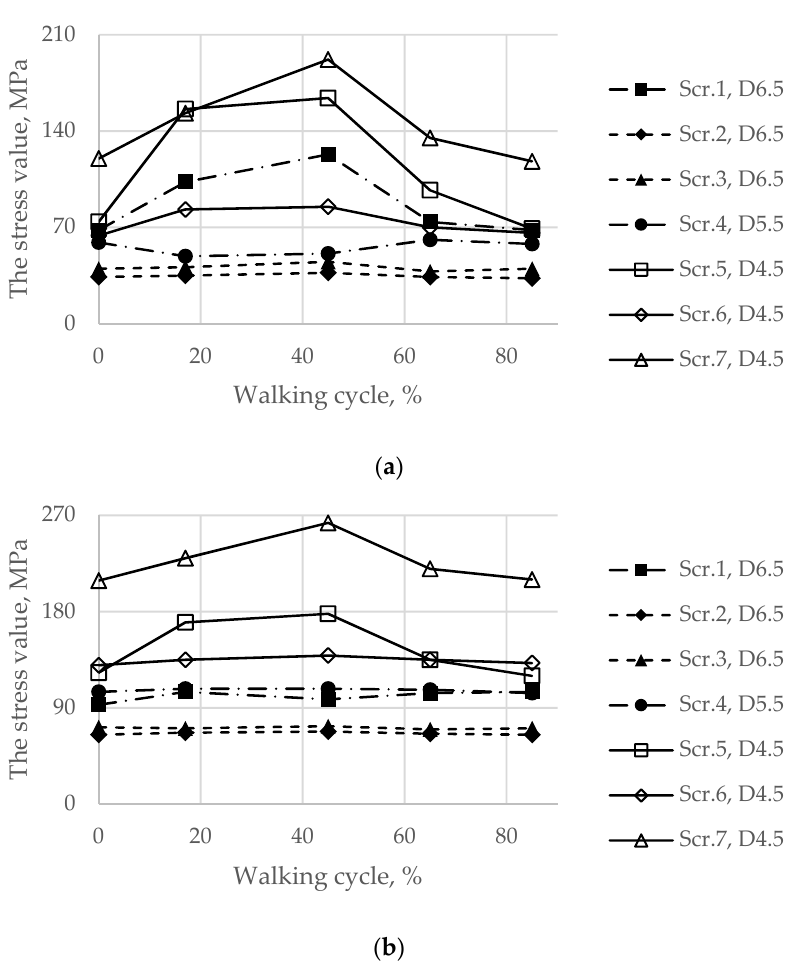
Figure 11. Maximum von Mises stress in each of the screws with pretension in the walking cycle phases: ( a ) pretension force equal to 500 N; ( b ) pretension force equal to 1000 N.